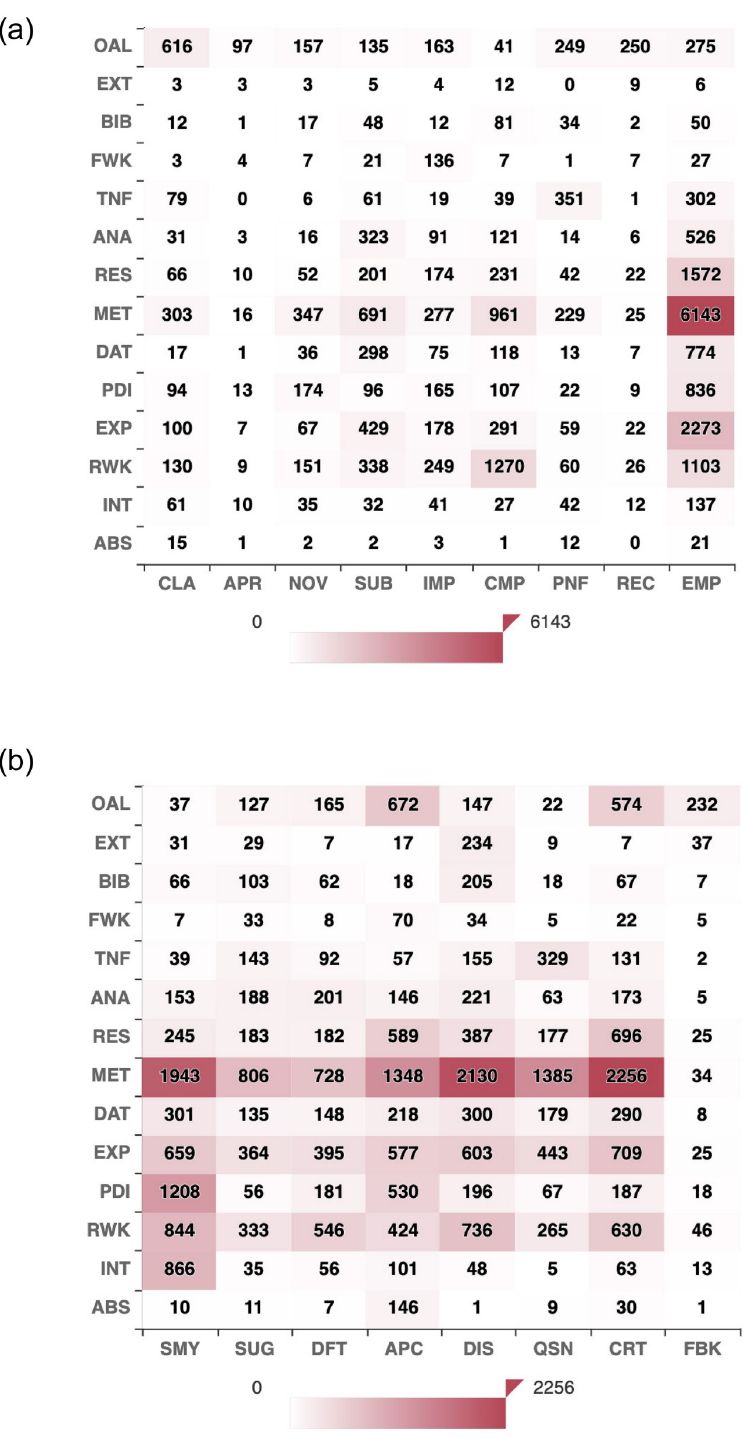
PLOS ONE | https://doi.org/10.1371/journal.pone.0259238 January 27,